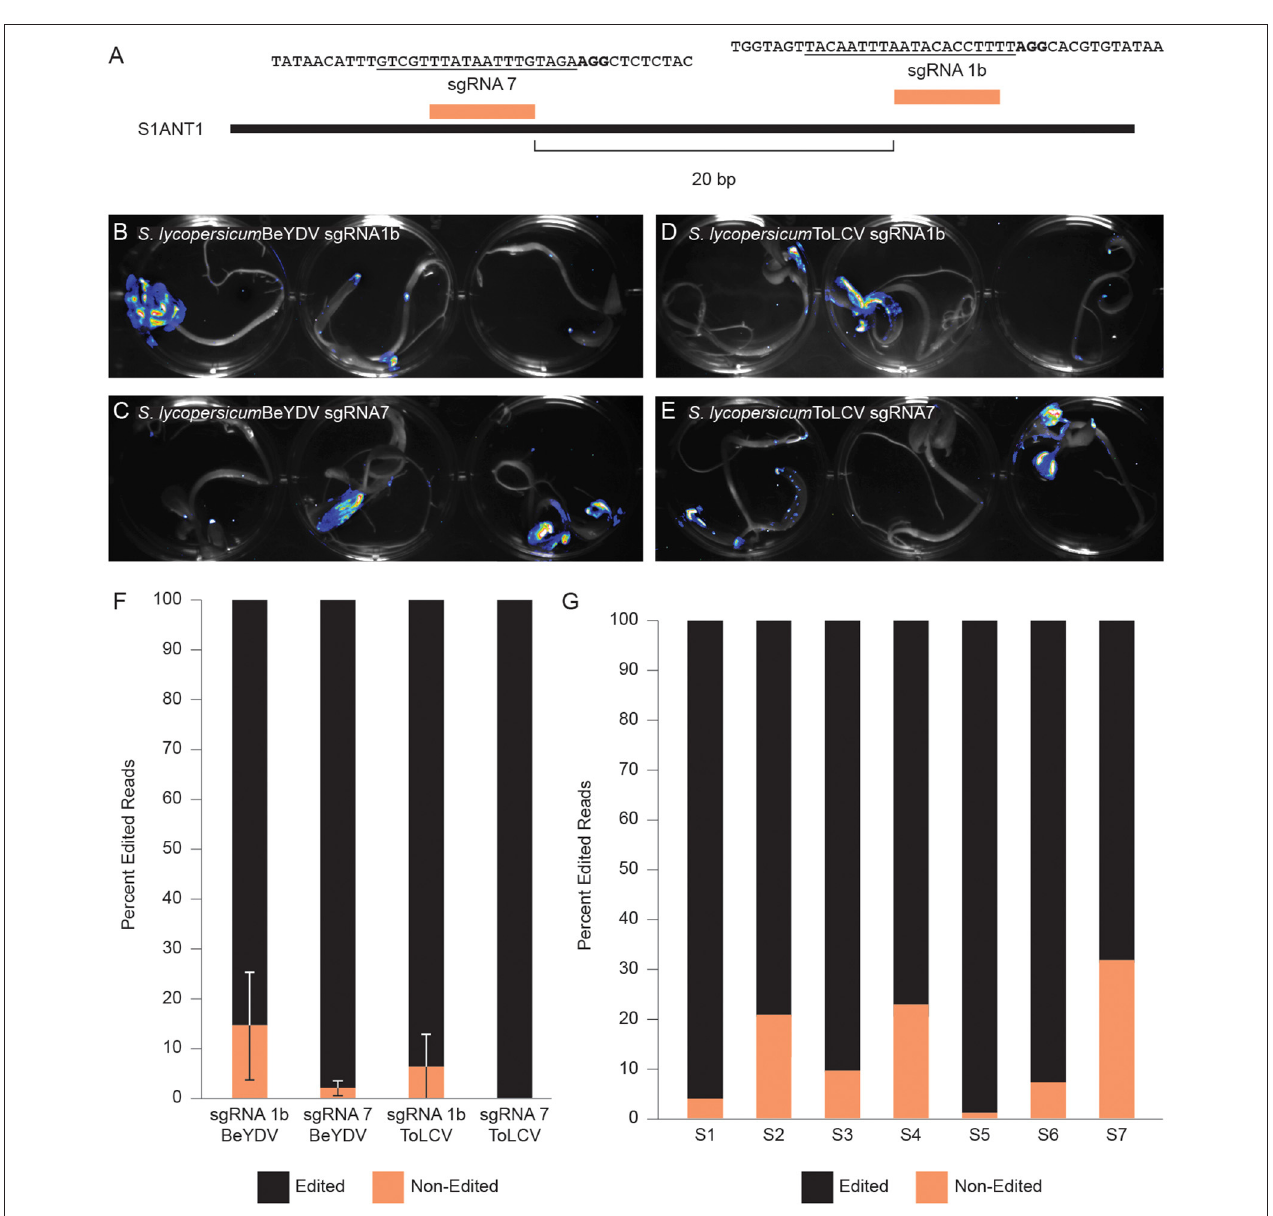
FIGURE 5 | Comparing gene editing efficiencies at a target locus in tomato. (A) Two distinct sgRNAs targeting the promoter of SlANT1 were delivered via Fast-TrACC to tomato seedlings. The sequences targeted by the sgRNAs are underlined and the PAM sequence is in bold. The T-DNAs carried SpCas9, the sgRNAs and a luciferase reporter. These T-DNA sequences contain the required components to form either a BeYDV or ToLCV replicon. Delivery to tomato seedlings of BeYDV replicons with sgRNA1b (B) or sgRNA7 (C) or ToLCV replicons with sgRNA1b (D) or sgRNA7 (E) was monitored by luciferase expression and was variable across seedlings. From sectors showing strong luminescence, DNA was collected, and the target site was PCR- amplified and submitted for NGS. Based on the NGS sequencing results, sgRNA1b was more effective at generating edits (F) than sgRNA7. Additionally, the ToLCV replicon showed little or no activity (F) ; Error bars represent ± s.d. When looking at individual seedlings treated with sgRNA1 on a BeYDV replicon, there was noticeable variability in the editing frequency (G) likely due to differential construct